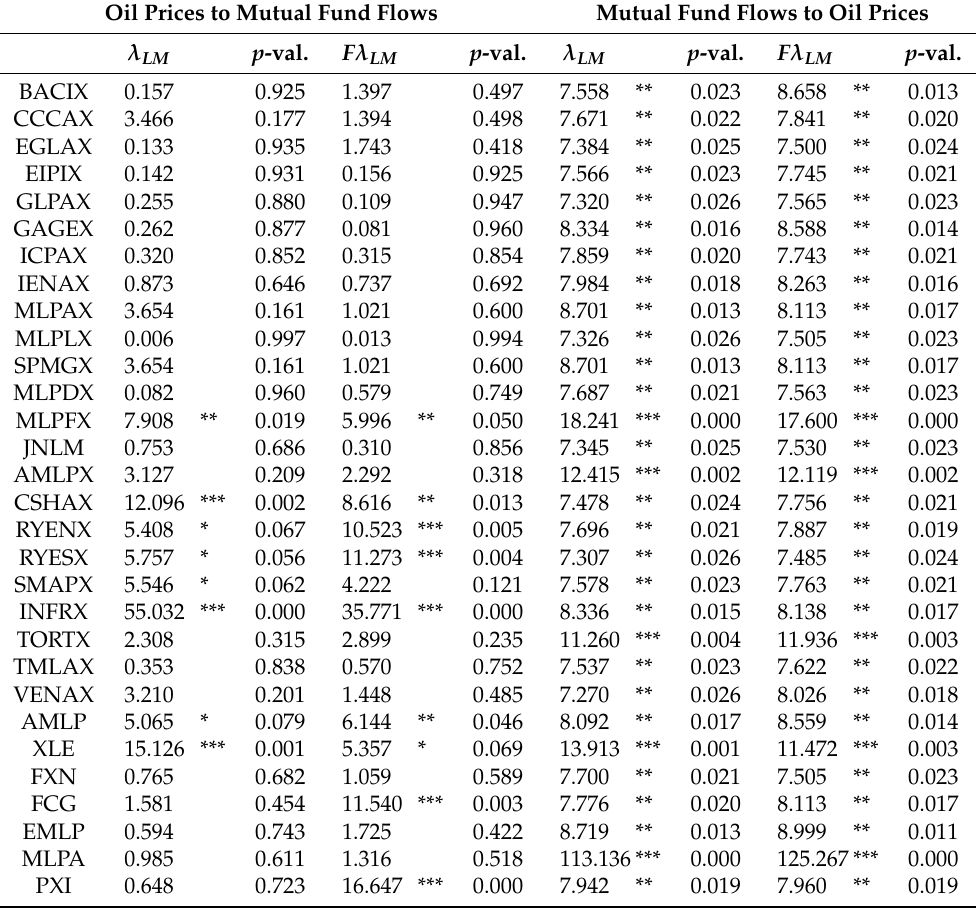
Table 5. Results for volatility transmission between oil prices and mutual fund flows. Oil Prices to Mutual Fund Flows Mutual Fund Flows to Oil